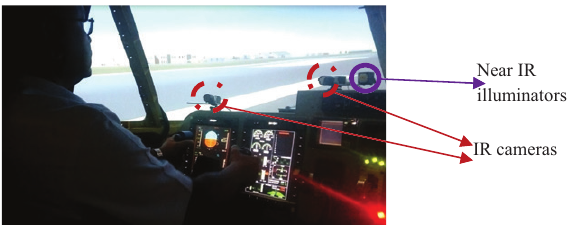
Figure 1. NAL Flight training device with cameras for eye